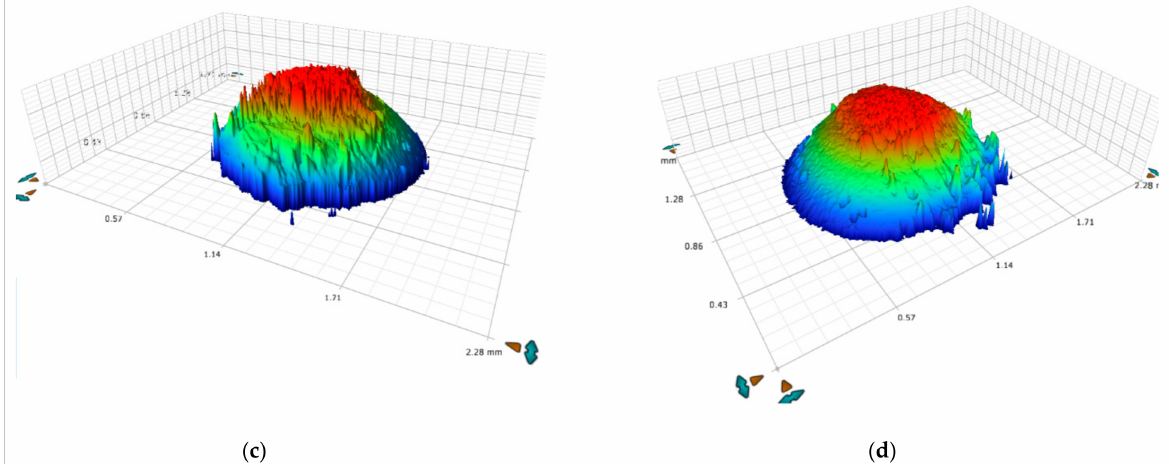
Figure 8. 3D profiles showing the wear on the: ( a ) ball run with 288 ◦ C austempered disks, ( b ) ball run with 380 ◦ C quenched- tempered disks, ( c ) ball run with 343 ◦ C austempered disks, and ( d ) ball run with 585 ◦ C quenched-tempered